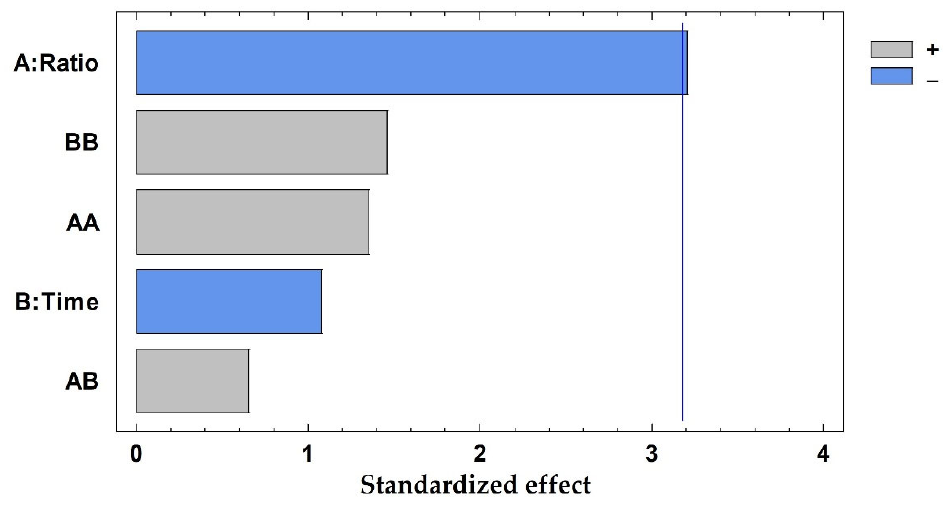
Figure 3. Pareto chart results from the total polyphenols extracted (mg/g dw) from pine needles using factorial design, A: solid-to-solvent ratio (g sample in 10 mL solvent); B: time of extraction (minutes). The vertical line marks 95% of